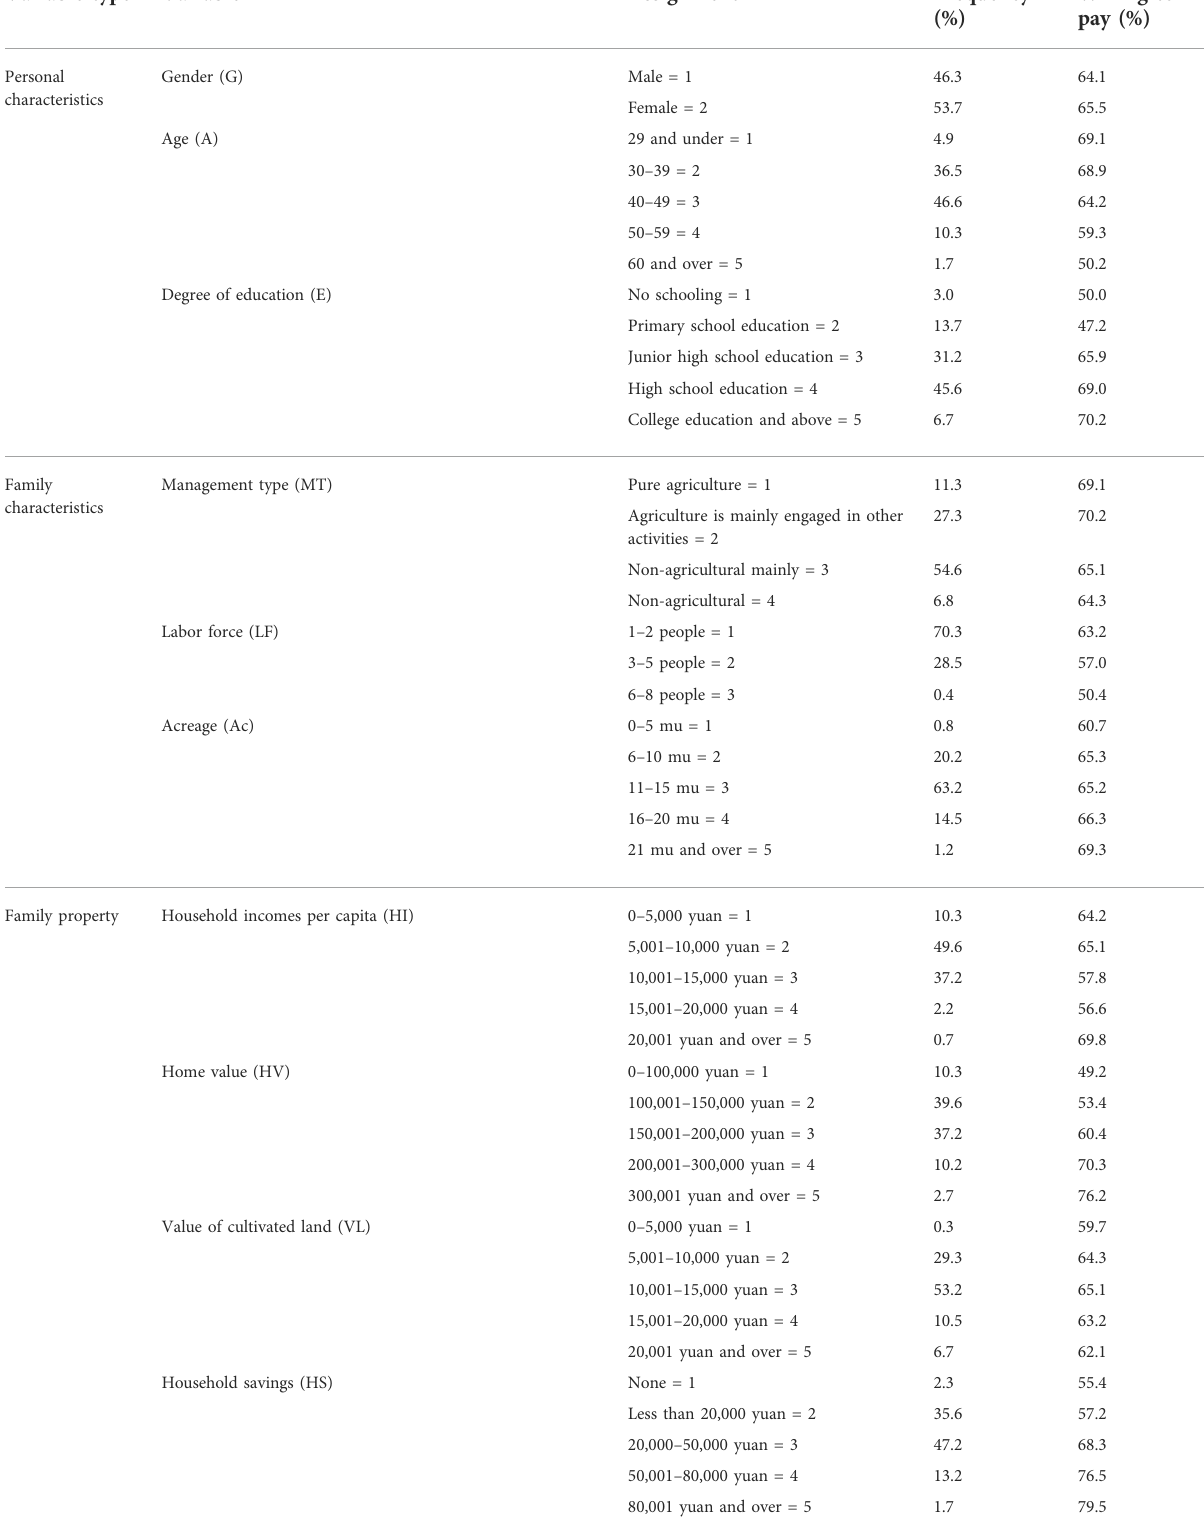
TABLE 4 Respondents ’ socio-demographic and willingness to pay